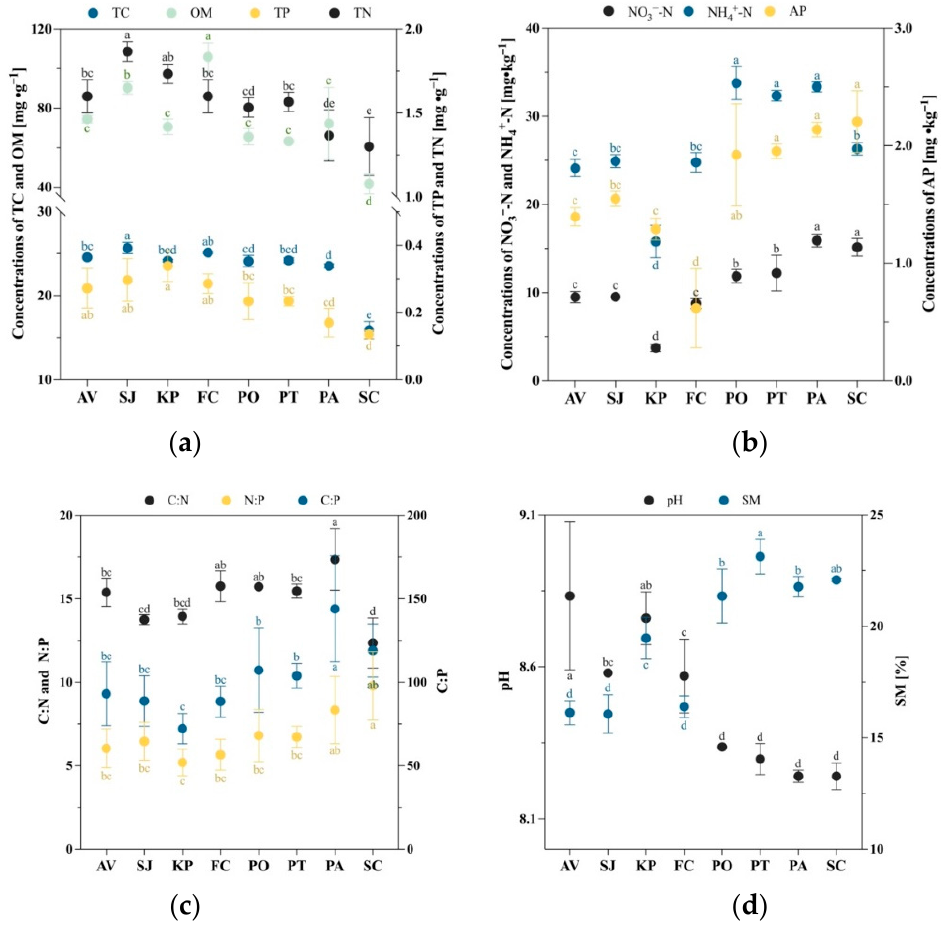
Figure 2. Rhizosphere chemical properties in different stands. Data present means ± st. errors; different letters (from a to d) in figure body indicate significant differences among tree species after